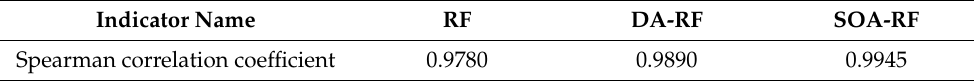
Table 7. Spearman correlation coefficient of each